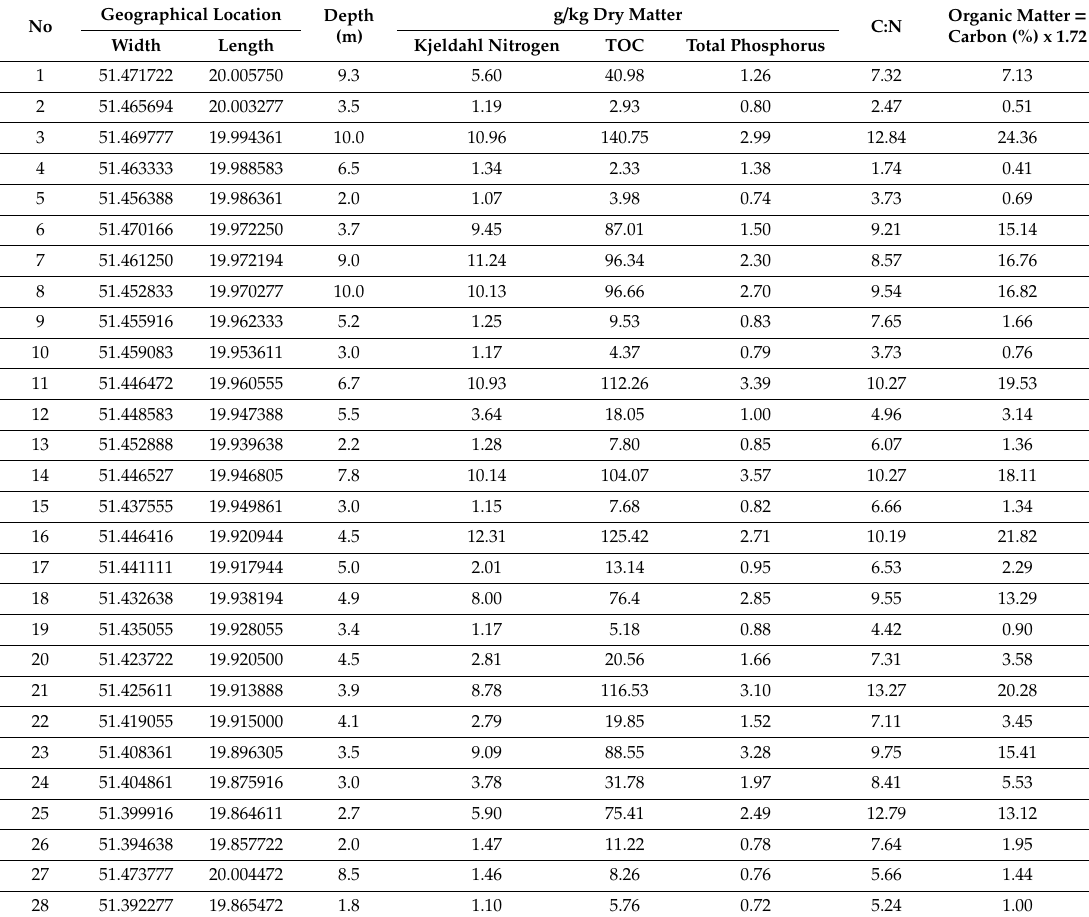
Table 2. Chemical composition of bottom sediments in the Sulej ó w Reservoir October